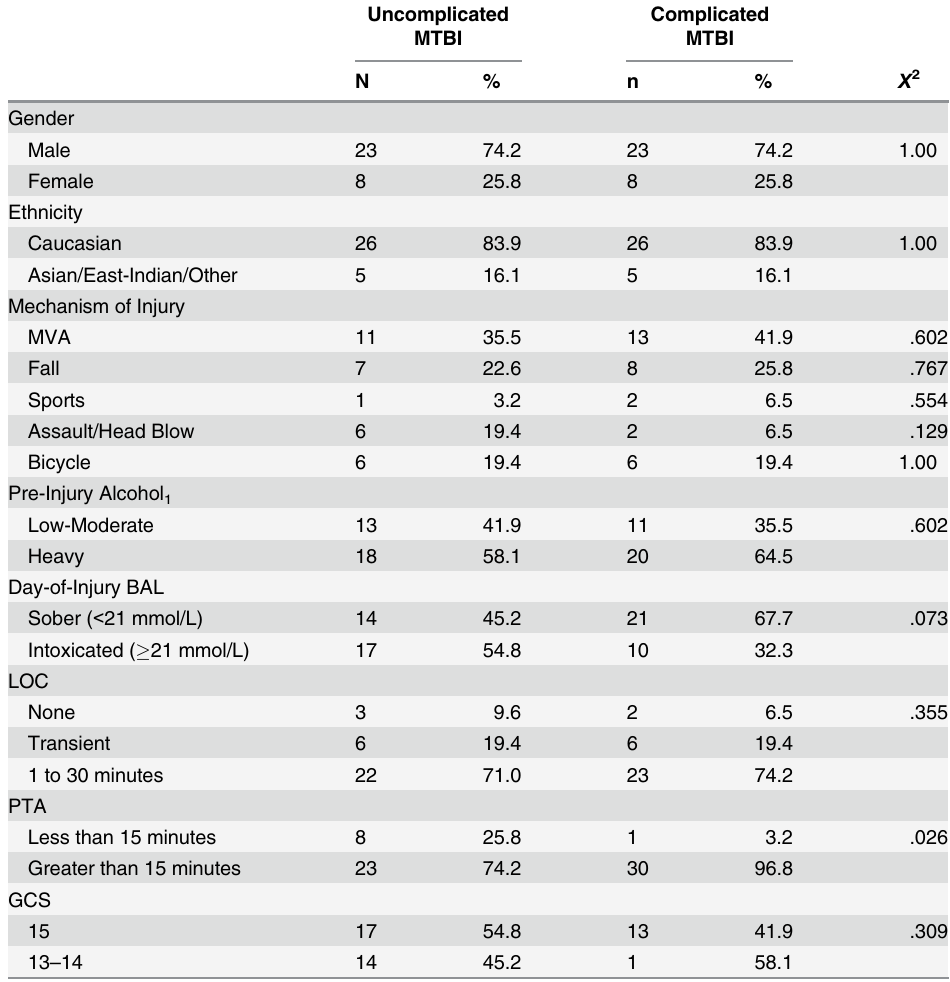
Table 3. Descriptive statistics and group comparisons of demographic and injury severity character- istics (categorical variables) by group. Uncomplicated